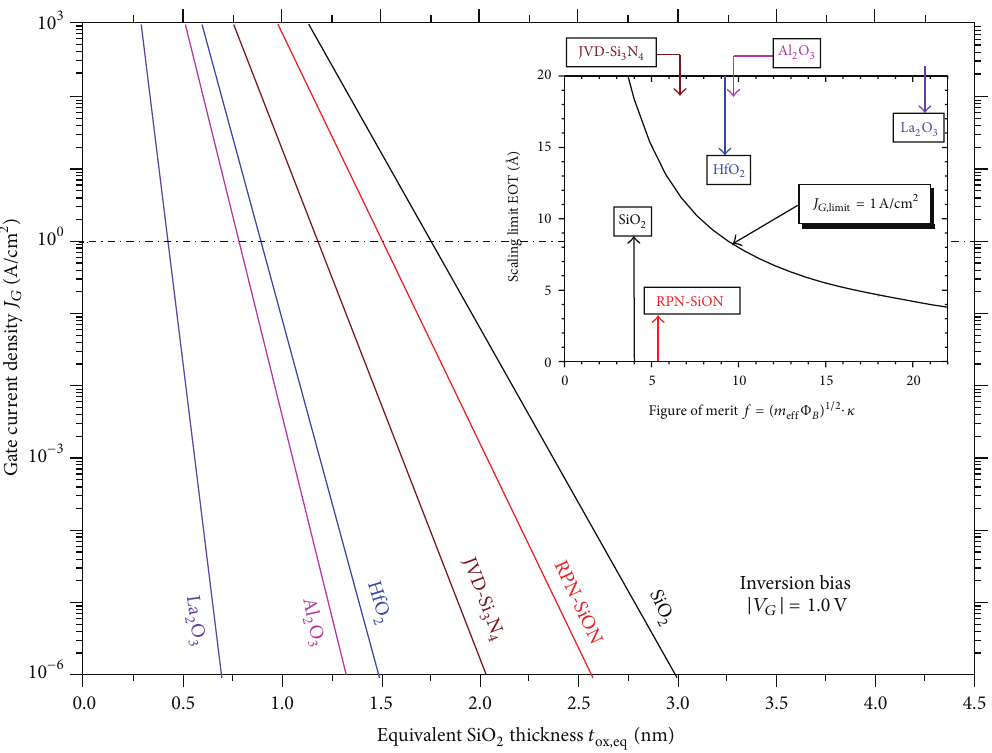
= 1 A/cm 2 [12]. limit